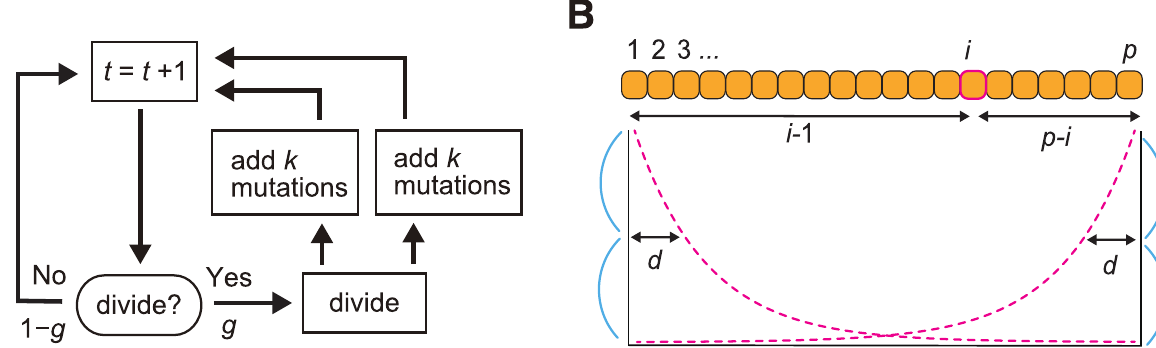
Fig 2. An agent-based model of cancer evolution. (A) A flowchart of the simulation. In each time step, a cell divides into two daughter cells with a probability g . In each cell division, each of the two daughter cells acquires k * Pois( m /2) mutations. (B) A growth rule on a one-dimensional lattice. Cell divides while pushing out neighboring cells on a one-dimensional lattice with free-ends. Resources are provided from both the ends and subject to exponential decays with a half-distance parameter d .